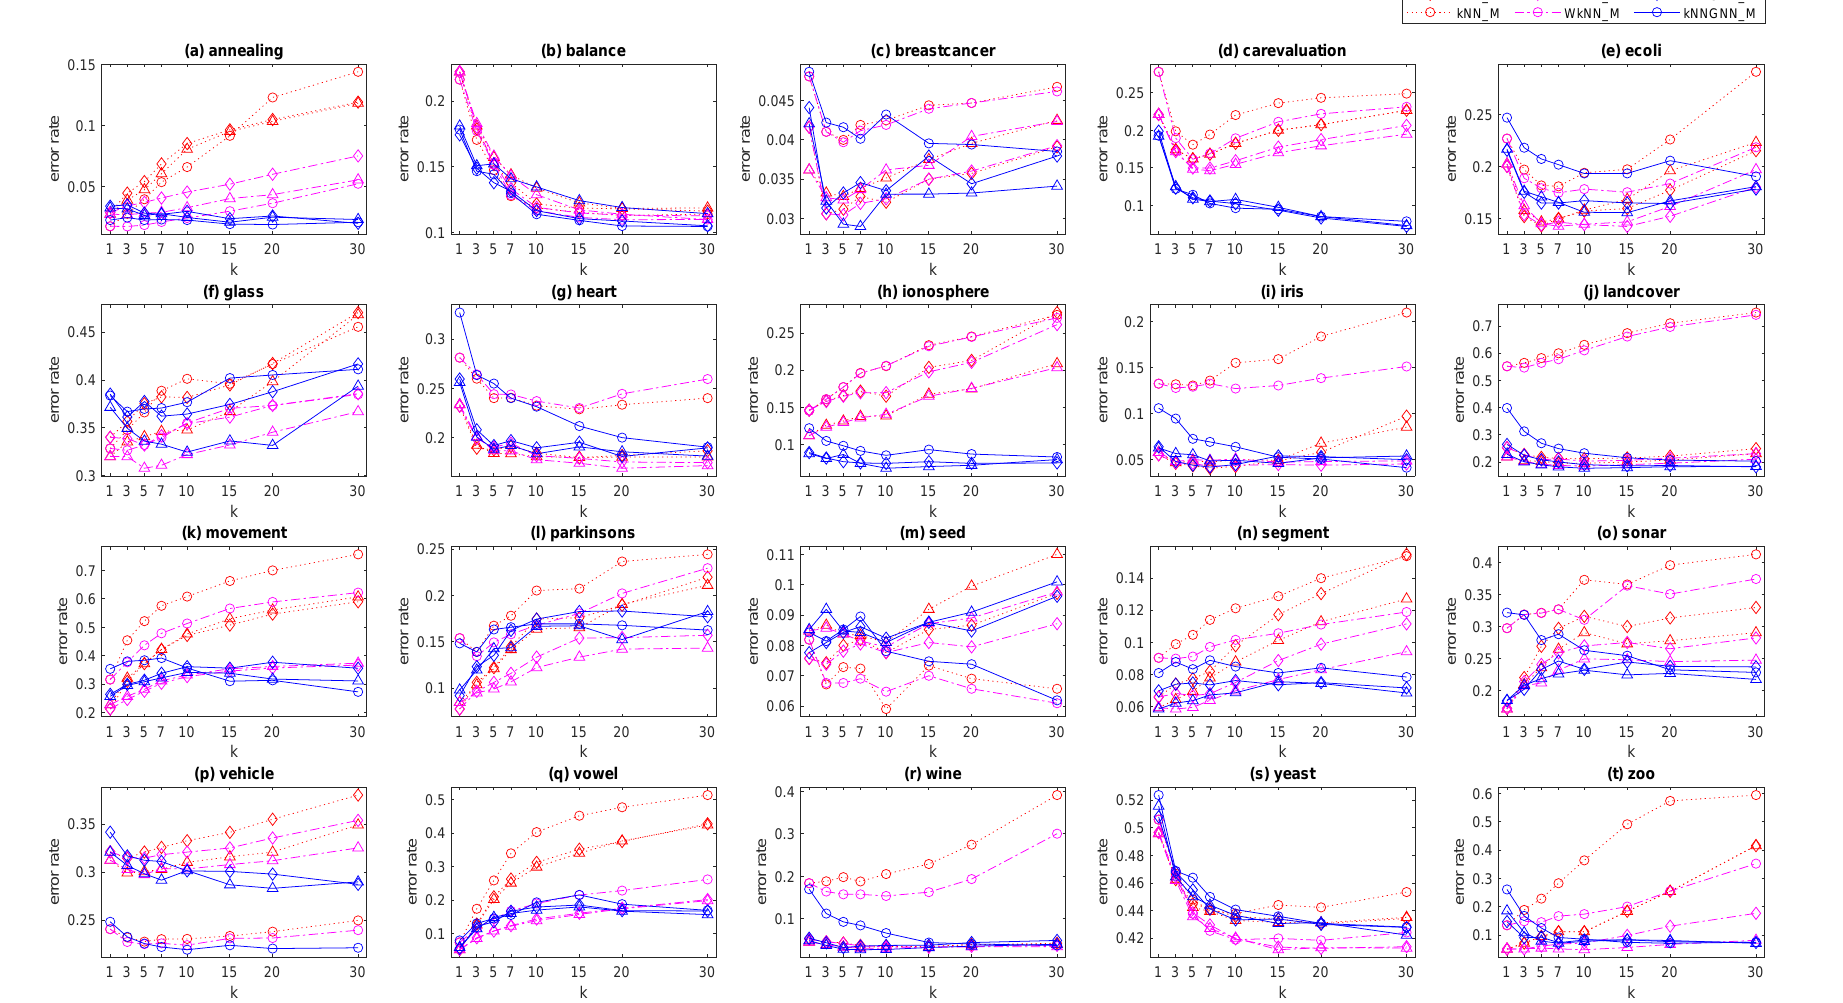
Figure 2. Error rate comparison with varying hyperparameter settings on classification